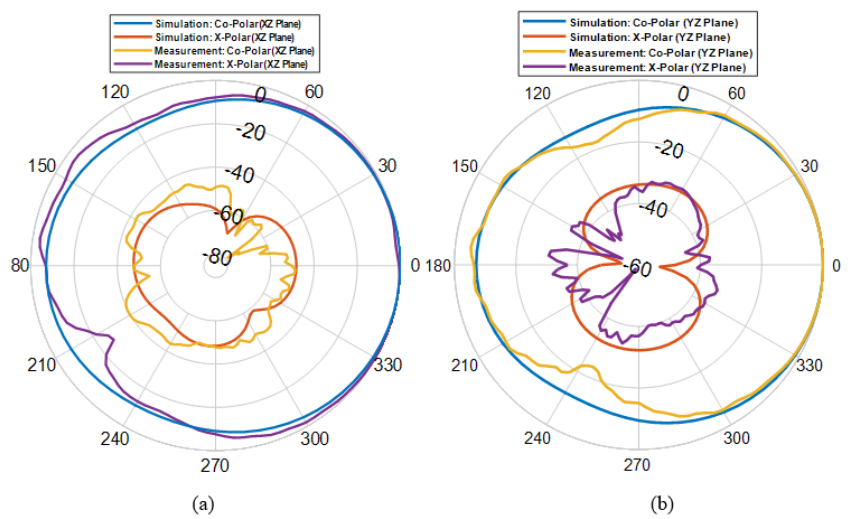
Figure 22. Simulated and measured radiation patterns of the single antenna at 2.4 GHz, ( a ) φ = 0 ◦ ,